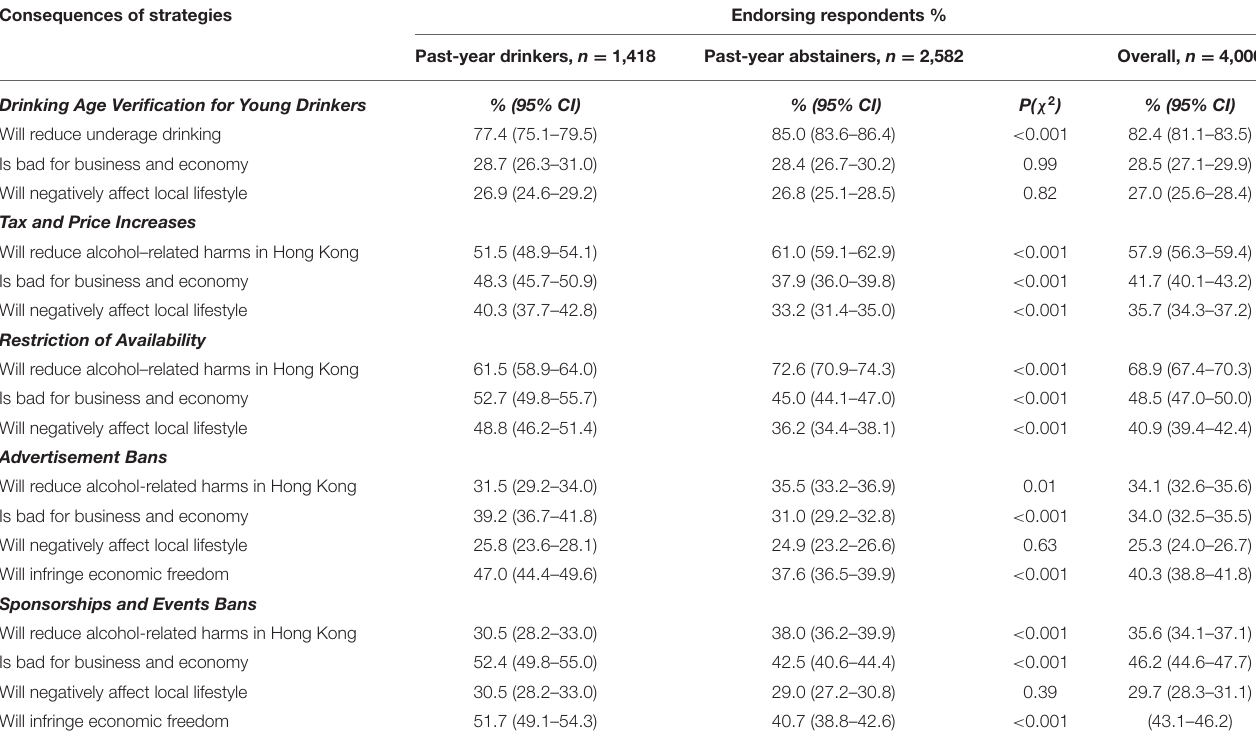
TABLE 5 | Perceived consequences of implementing alcohol harms reduction strategies among participants and by past-year drinking status ( n = 4,000). Consequences of